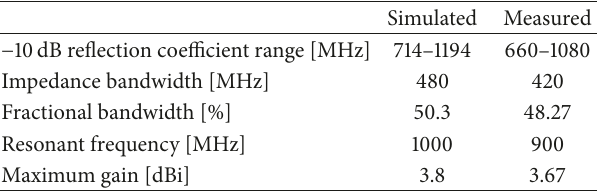
Table 2: Comprehensive results of the proposed